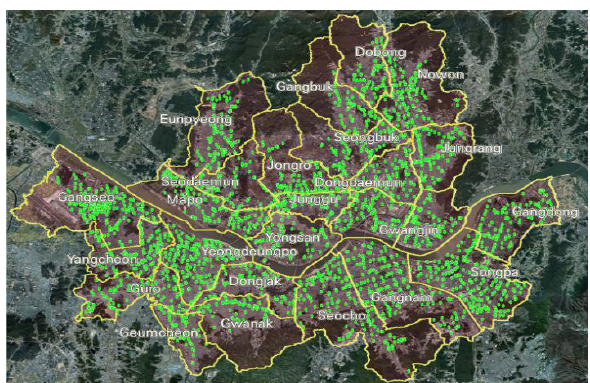
Figure 1 . Spatial Distribution of Public Bike Stations in